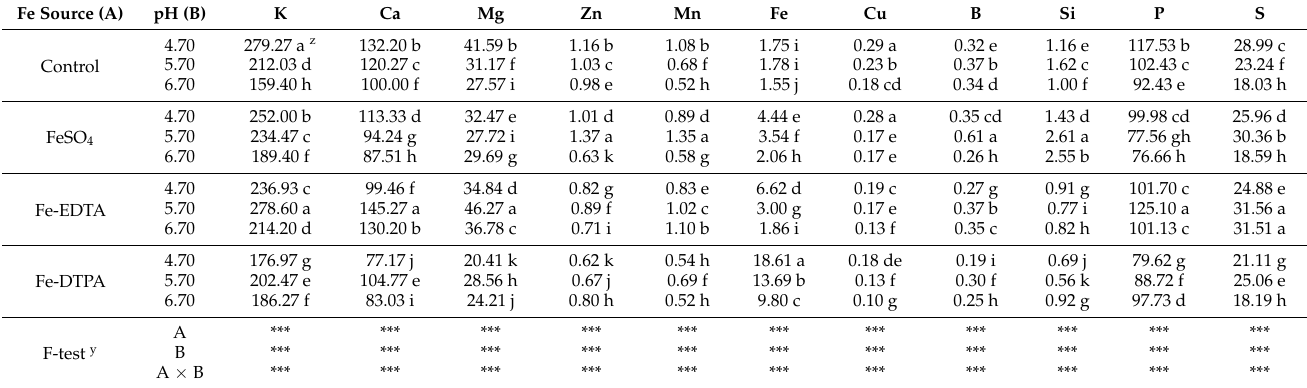
Table 3. Mineral contents in S. commixta after 6 weeks of culture (mg · g − 1 dry